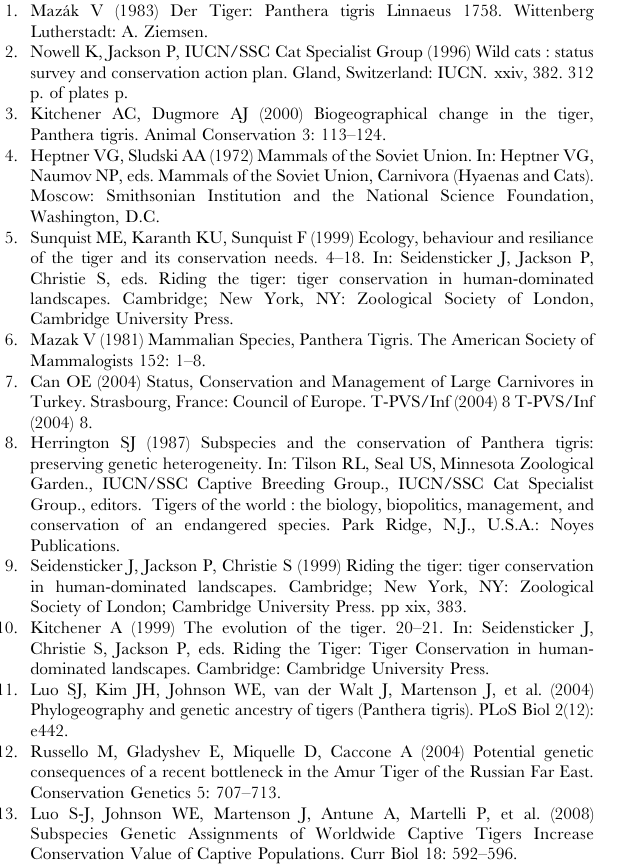
Table S2 P. t. virgata individuals PCR amplified and sequenced at each fragment